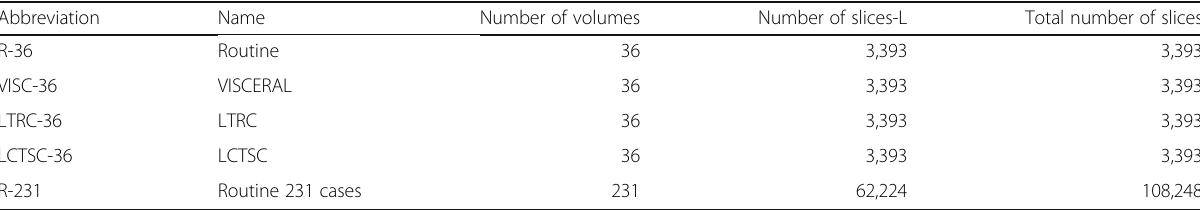
Table 1 Datasets used to train semantic segmentation